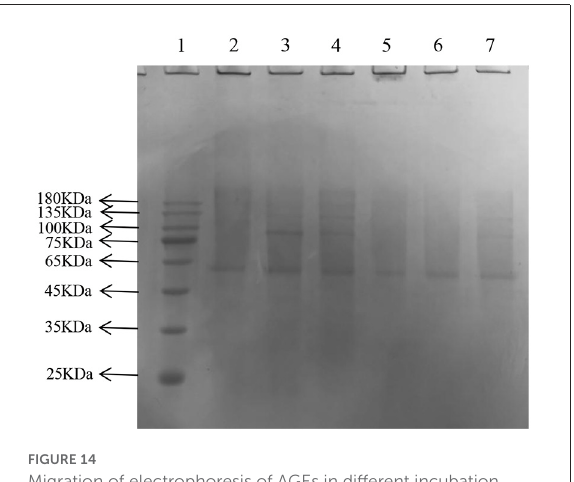
FIGURE14 Migration of electrophoresis of AGEs in different incubation systems of glycation systems. Lane: 1, Prestained Protein Ladder; 2, n-gly-LDL; 3,GNT ; 4, gly-LDL; 5, CEF; 6, PEF; 7,